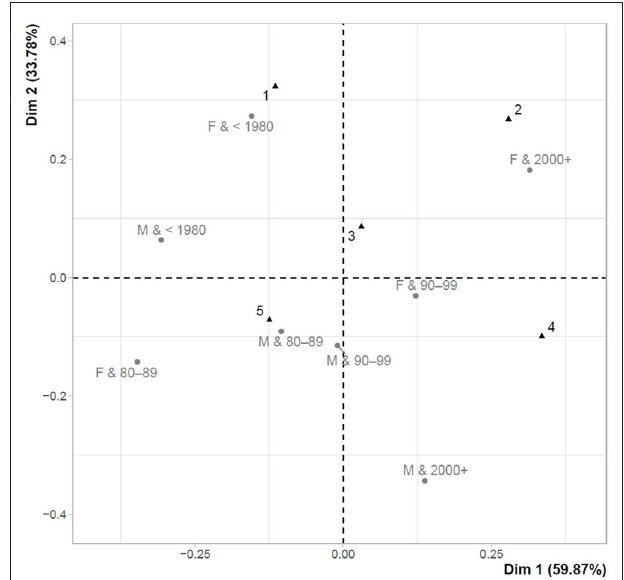
FIGURE 5 | Correspondence map for T2–perception of doubts about the accuracy of test results and gender-age